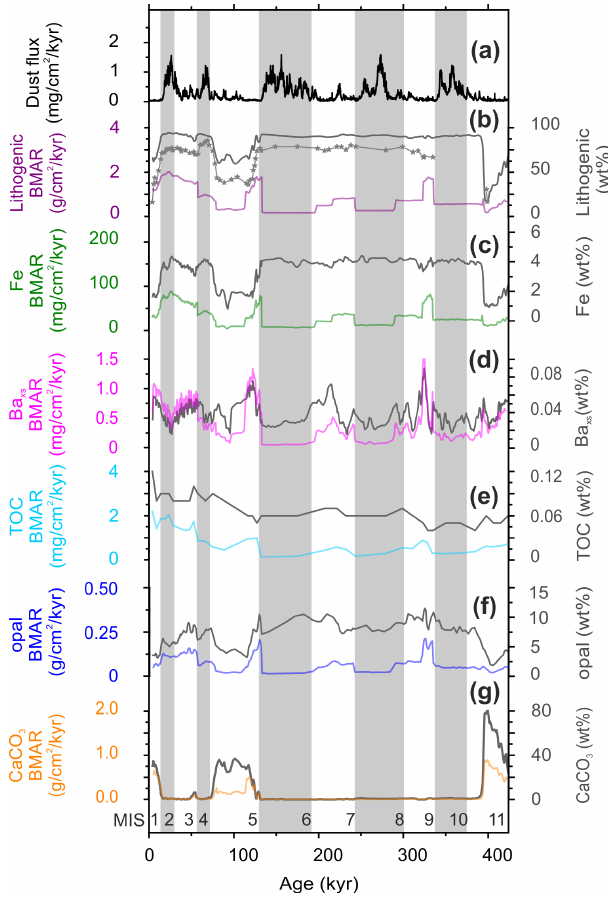
Figure 2. Southeastern Pacific (PS97/093-2) stratigraphy-based mass accumulation rates (BMARs) and percentages of individual components compared to dust flux in the EPICA Dome C (EDC) ice core (Lambert et al., 2008). (a) EDC dust flux; (b) lithogenic content (wt%; calculated from 100-[opal wt% + CaCO 3 wt % + 2 × TOCwt%], grey line), lithogenic content based on 232 Th (grey stars) and lithogenic BMAR (purple line); (c) Fe content (grey line) and Fe BMAR (green line); (d) Ba xs content (grey line) and Ba xs BMAR (pink line); (e) TOC content (light grey line) and TOC BMAR (light blue line); (f) opal content (wt%; grey line) and opal BMAR (blue line); (g) CaCO 3 content (grey line) and CaCO 3 BMAR (orange line). Numbers in the lower part of the figure in- dicate Marine Isotope Stage (MIS). Vertical grey bars mark glacial stages according to Lisiecki and Raymo (2005).